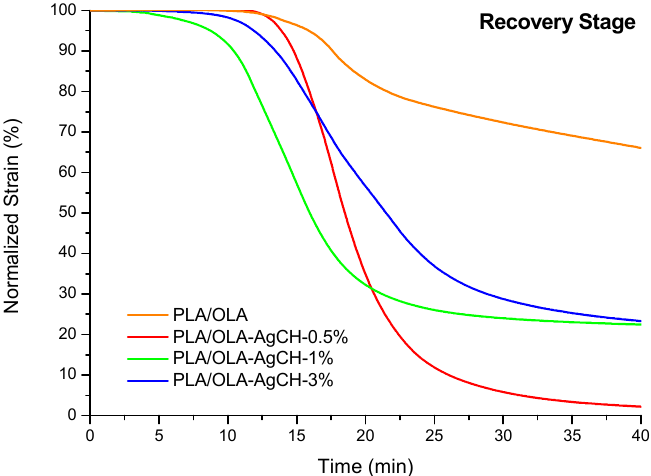
Figure 8. Normalized recovered strain with time for neat PLA / OLA and its nanocomposites containing 0.5, 1 and 3 wt.% of AgCH-NPs.